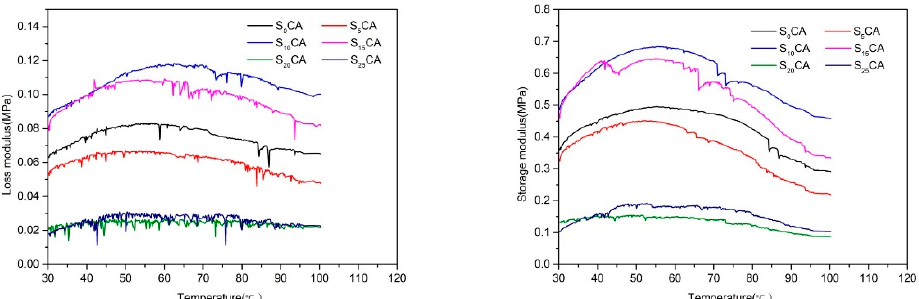
Figure 7. Storage modulus and loss modulus versus temperature curves of the aerogels with different starch content.